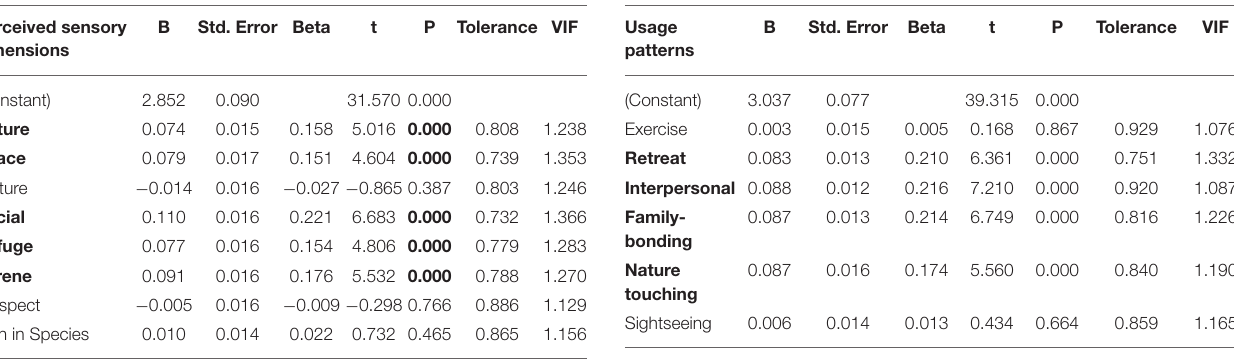
TABLE 6 | The regression model of PSDs on PRS. TABLE 7 | The regression model of UPs on PRS.